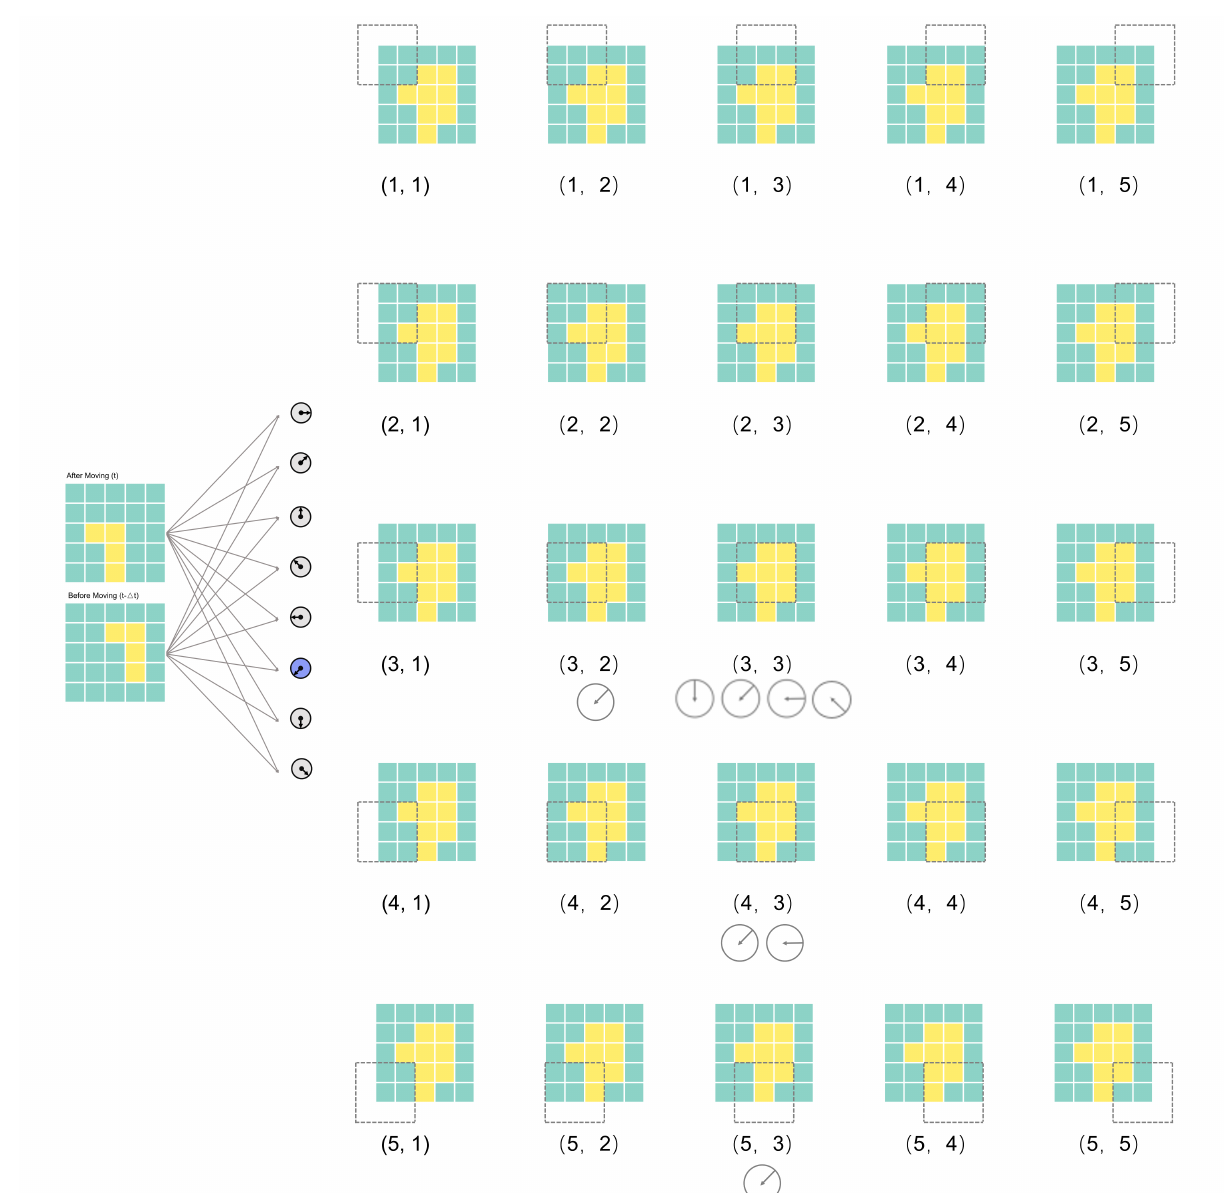
Figure 4. The mechanism of global motion direction detection, local motion direction detection neurons are arrayed in 5 × 5 regions to detect the two-dimensional receptive